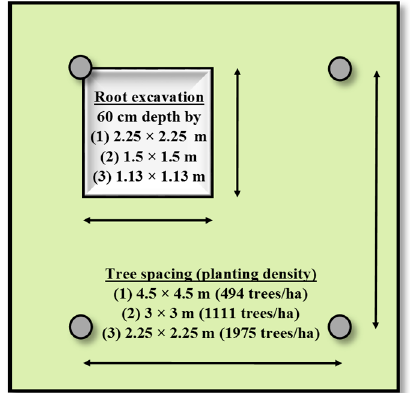
Scheme 1. Design for coarse root biomass sampling of a single tree. Size of excavated pits represents 25% of the surface area occupied by a single tree (grey square), and thus varied according to the three spacings (or planting densities) selected. Dark grey circles represent